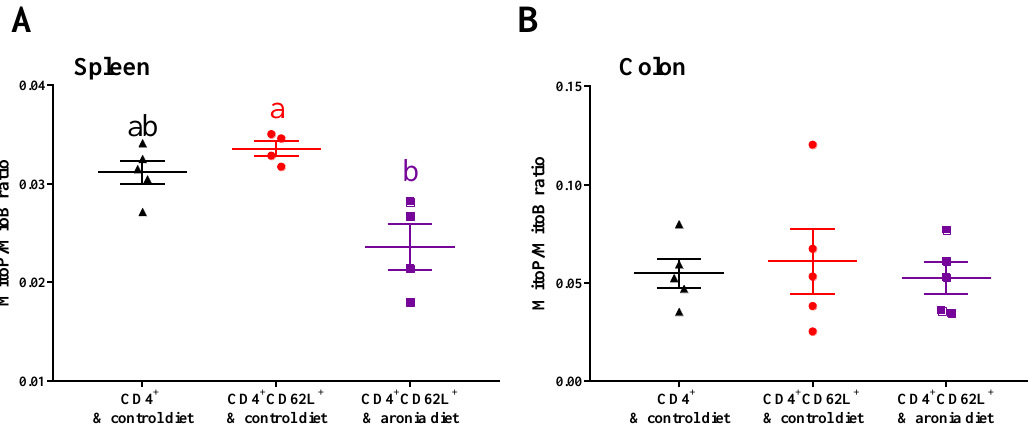
Figure 3. Aronia consumption reduces mitochondria H 2 O 2 . Splenic CD4 + CD62L + cells from C57BL/6J mice were transferred to Rag1 - / - mice. Mice consumed the AIN-93M diet (colitic control) or aronia-supplemented diet for five weeks. A third group of Rag1 - / - mice received splenic CD4 + cells, consumed AIN-93M diet, and served as non-colitic control. MitoP / MitoB ratio in ( A ) spleen and ( B ) colon ( n = 4–5 / group). Groups bearing di ff erent letters indicate significant di ff erences between treatments ( p < 0.05). Data are means ±